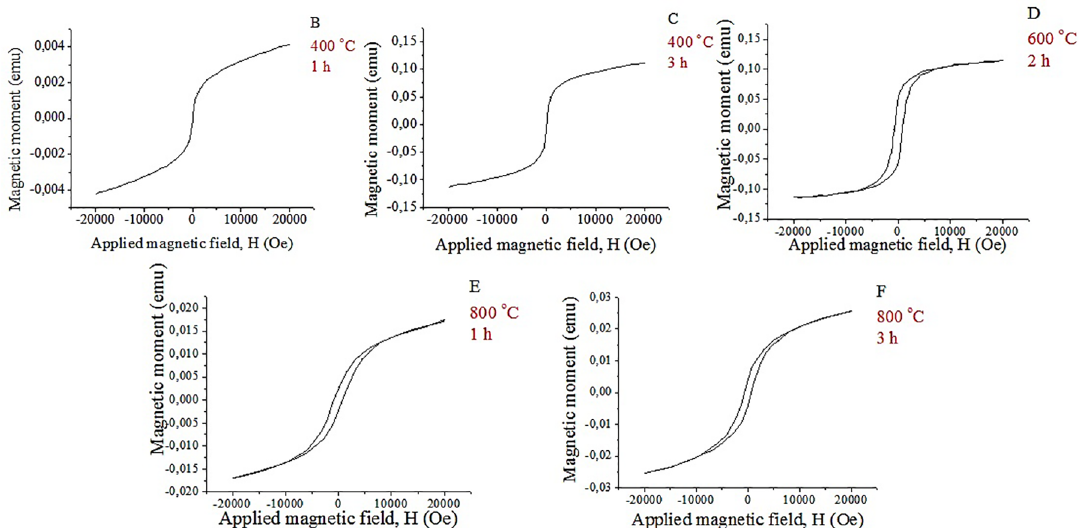
Figure 6. Magnetometric analysis of the samples treated in the CO